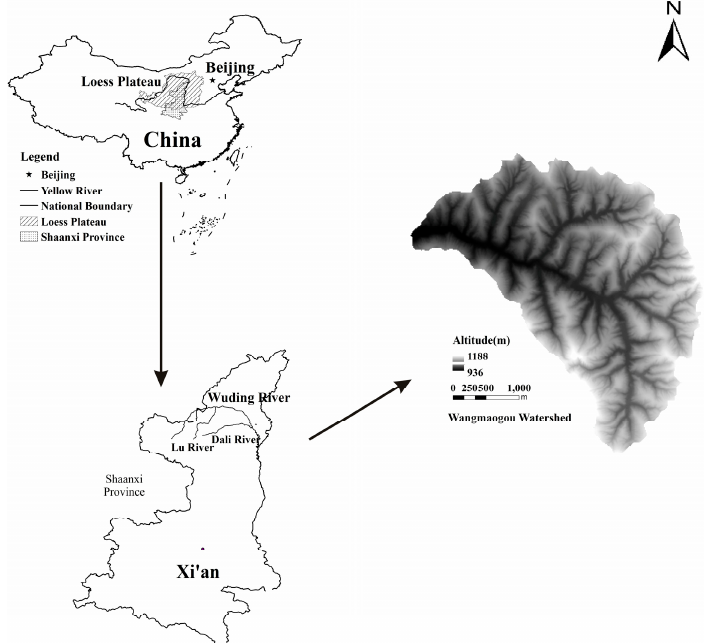
Figure 1. The geographical location of tested soil.